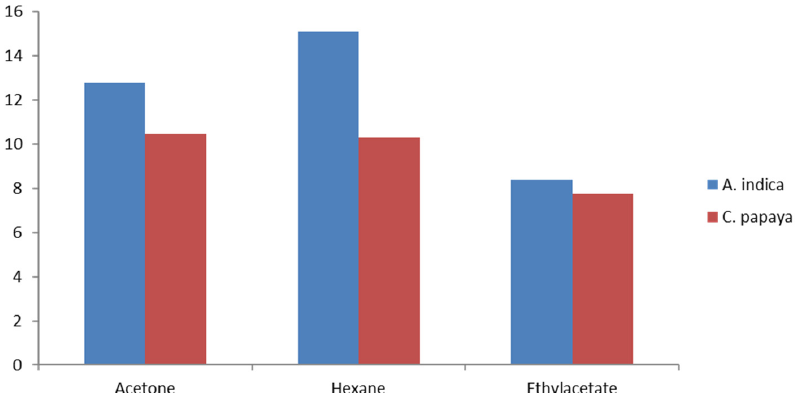
Figure 1. Percentage yield of acetone, hexane and ethyl acetate extracts of Carica papaya and Azadirachta indica